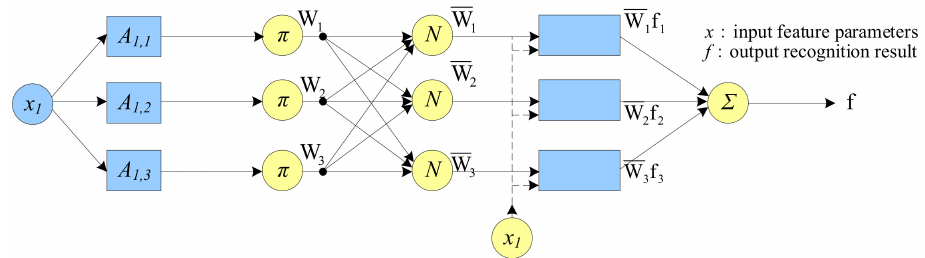
Figure 27. Schematic diagram of ANFIS architecture for partial discharge defect classification.